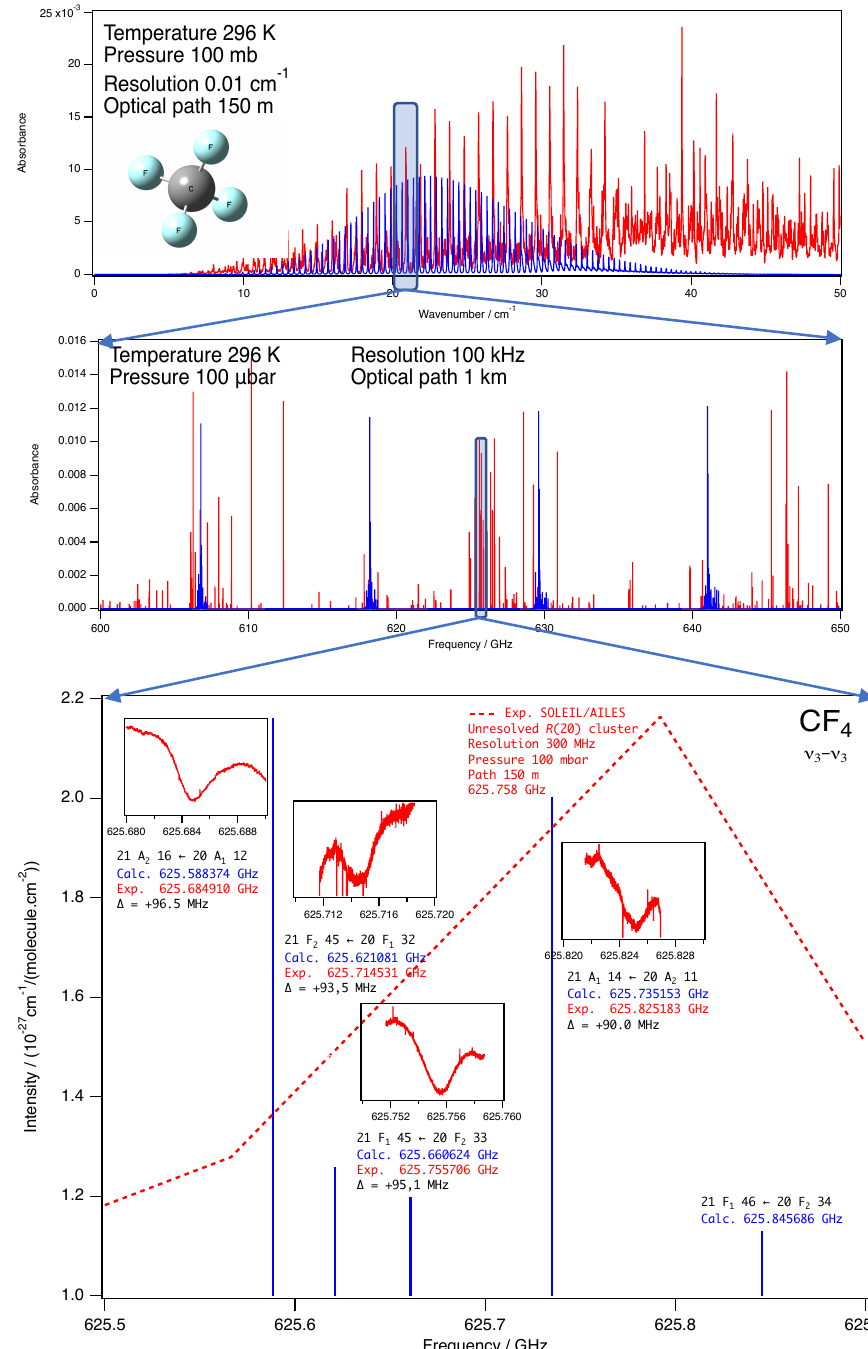
Figure 6. Upper panel: Simulation of the CF 4 THz absorbance in the conditions of the synchrotron-based FT-Far-IR measurements (see Ref. [36]), namely a resolution of 0.01 cm − 1 , a gas pressure of 100 mbar and a path-length of 150 m. Middle panel: Simulation of the CF 4 THz absorbance measured in the frequency range accessible by FP-TAS at a resolution of 100 kHz with a gas pressure of 100 µ bar and an effective path-length of 1 km. For both simulations, ground state transitions are in blue, ν 3 = 1 hot band transitions are in red. Lower panel: Zoom on experimental individual rotational lines ( R ( 20 ) cluster in the ν 3 ← ν 3 hot band) measured by FP-TAS. The experimental THz frequencies are determined by the microwave synthesiser used to drive the AMC. The microwave synthesiser is referenced to a time signal provided by a GPS receiver. The calculated frequencies are determined using the STDS software [27]. Dashed red line correspond to the FT-Far-IR synchrotron-based measurements at a pressure of 100 mbar and a resolution of 0.01 cm − 1